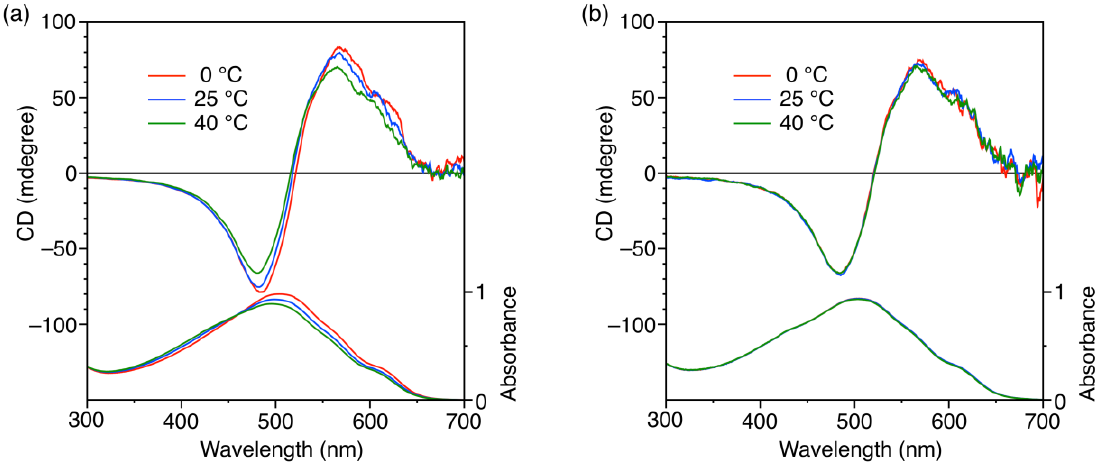
Figure 5. CD and absorption spectra of the micelles comprising ( S )-poly- 1a - b -poly- 3 ( a ) before and ( b ) after shell crosslinking in water at various temperatures.